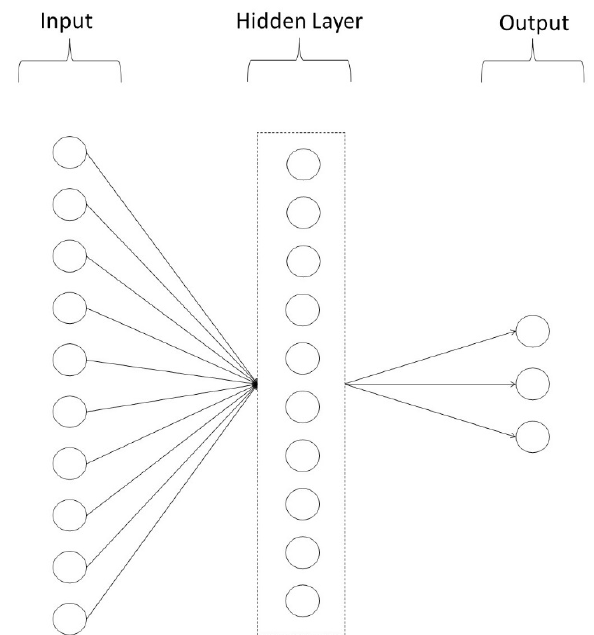
Figure 3. Higher-level Psychopathology Artificial Neural Network Model. Note. Depiction of the higher-level psychopathology artificial neural network model used in this research. The first layer of the model contains 10 input units consisting of age, gender, and the eight neurocognitive tasks. The second layer is the hidden layer consisting of 10 units. The final layer is the output layer consisting of three output units, namely internalising, externalising, and the p -factor.